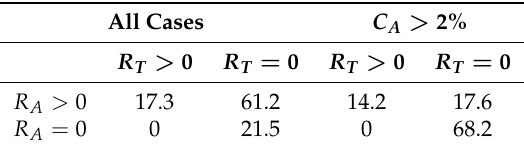
Table 1. Contingency table lists relative occurrence (%) of rain-rate combinations for R T (along-track rain rate) and R A (area rain rate) from 234,368 available cases. In contrast to the left part of the table, the right part sets R A = 0 if C A ≤ 2%. Note that tracks are always located completely within the area such that R T = 0 can only occur if R A = 0 (no false detections